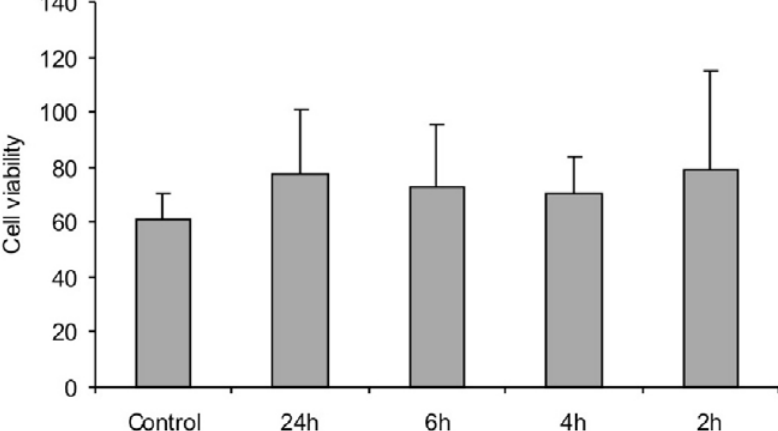
FIGURE 3- Number of viable cells counted in contact with artificial saliva over 2, 4, 6 and 24 h, expressed as percentage of the viable cells in the total number of cells. Data are shown as mean and bar indicates standard deviation (n=4)